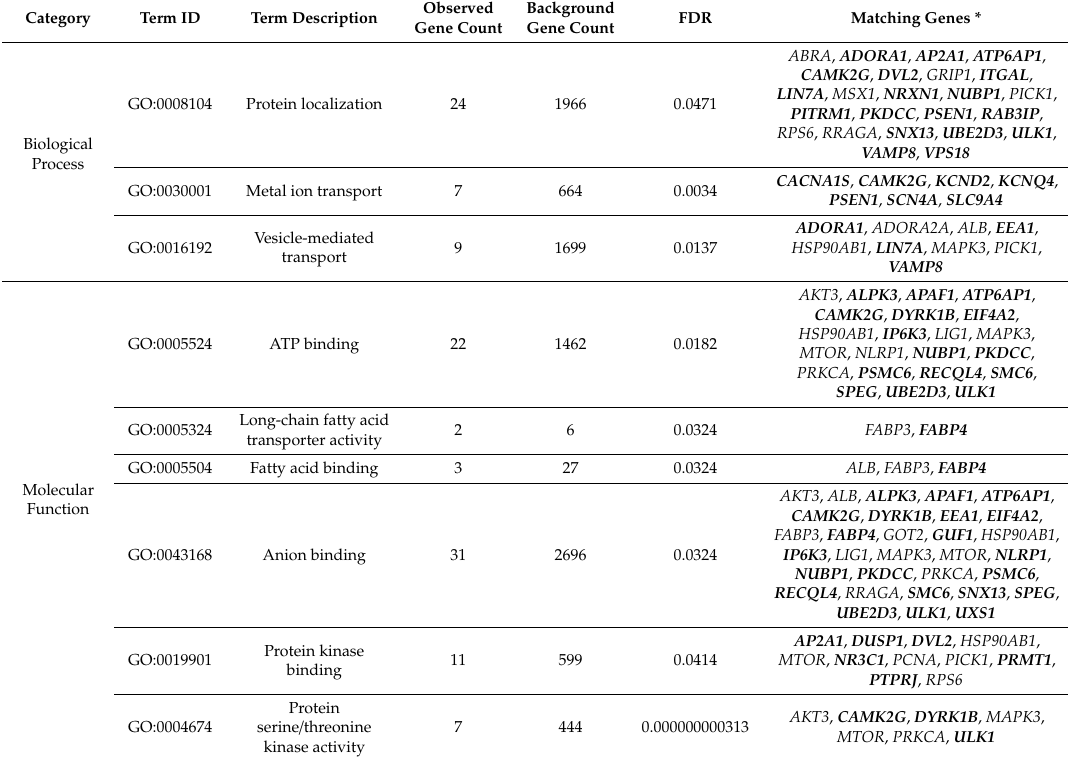
Figure 2. Heatmap gene cluster classification for the class I and class II muscle samples. C1 (white) and C2 (black) refers to the cluster 1 and cluster 2, respectively. Using the expression for each gene (in rows) and sample (in columns), the heatmap was generated by the R package “plots”. Table 2. Functional gene ontology (GO) categories enriched in the crossbred